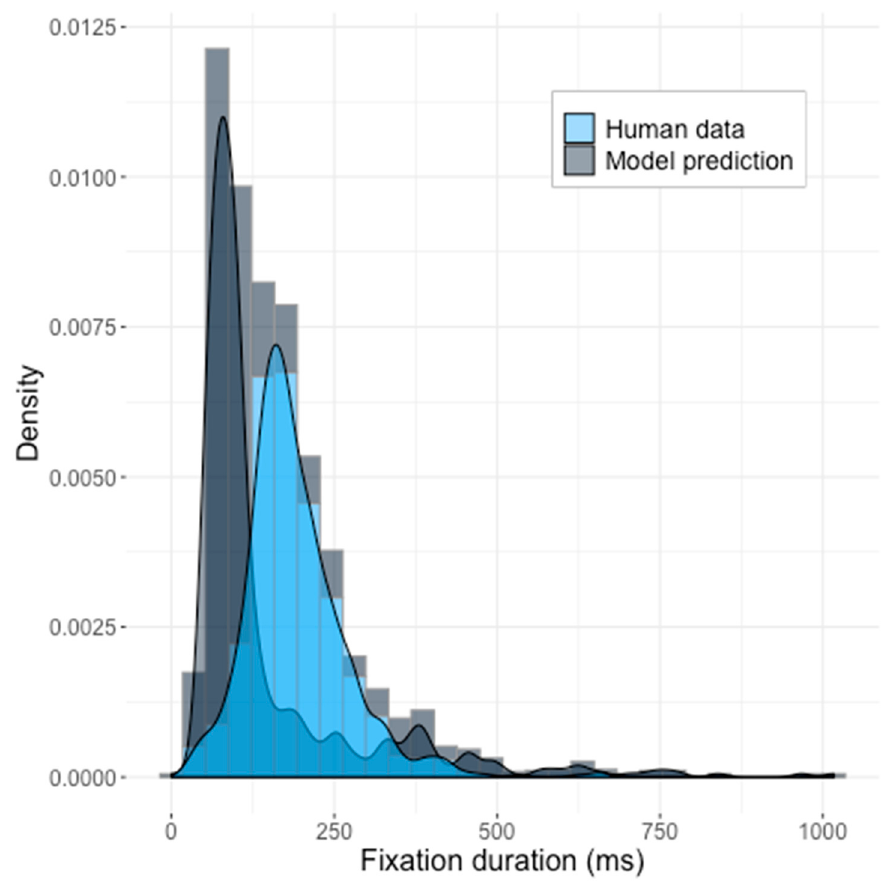
Figure 4. The predictions of the Saliency Model with the default parameters suggested by Walther and Koch [5] against the human data. Z-test statistics: z = 16.38, p < 2.2 × 10 − 16 . KS-statistics D = 0.58067, p < 2.2 × 10 − 16 .